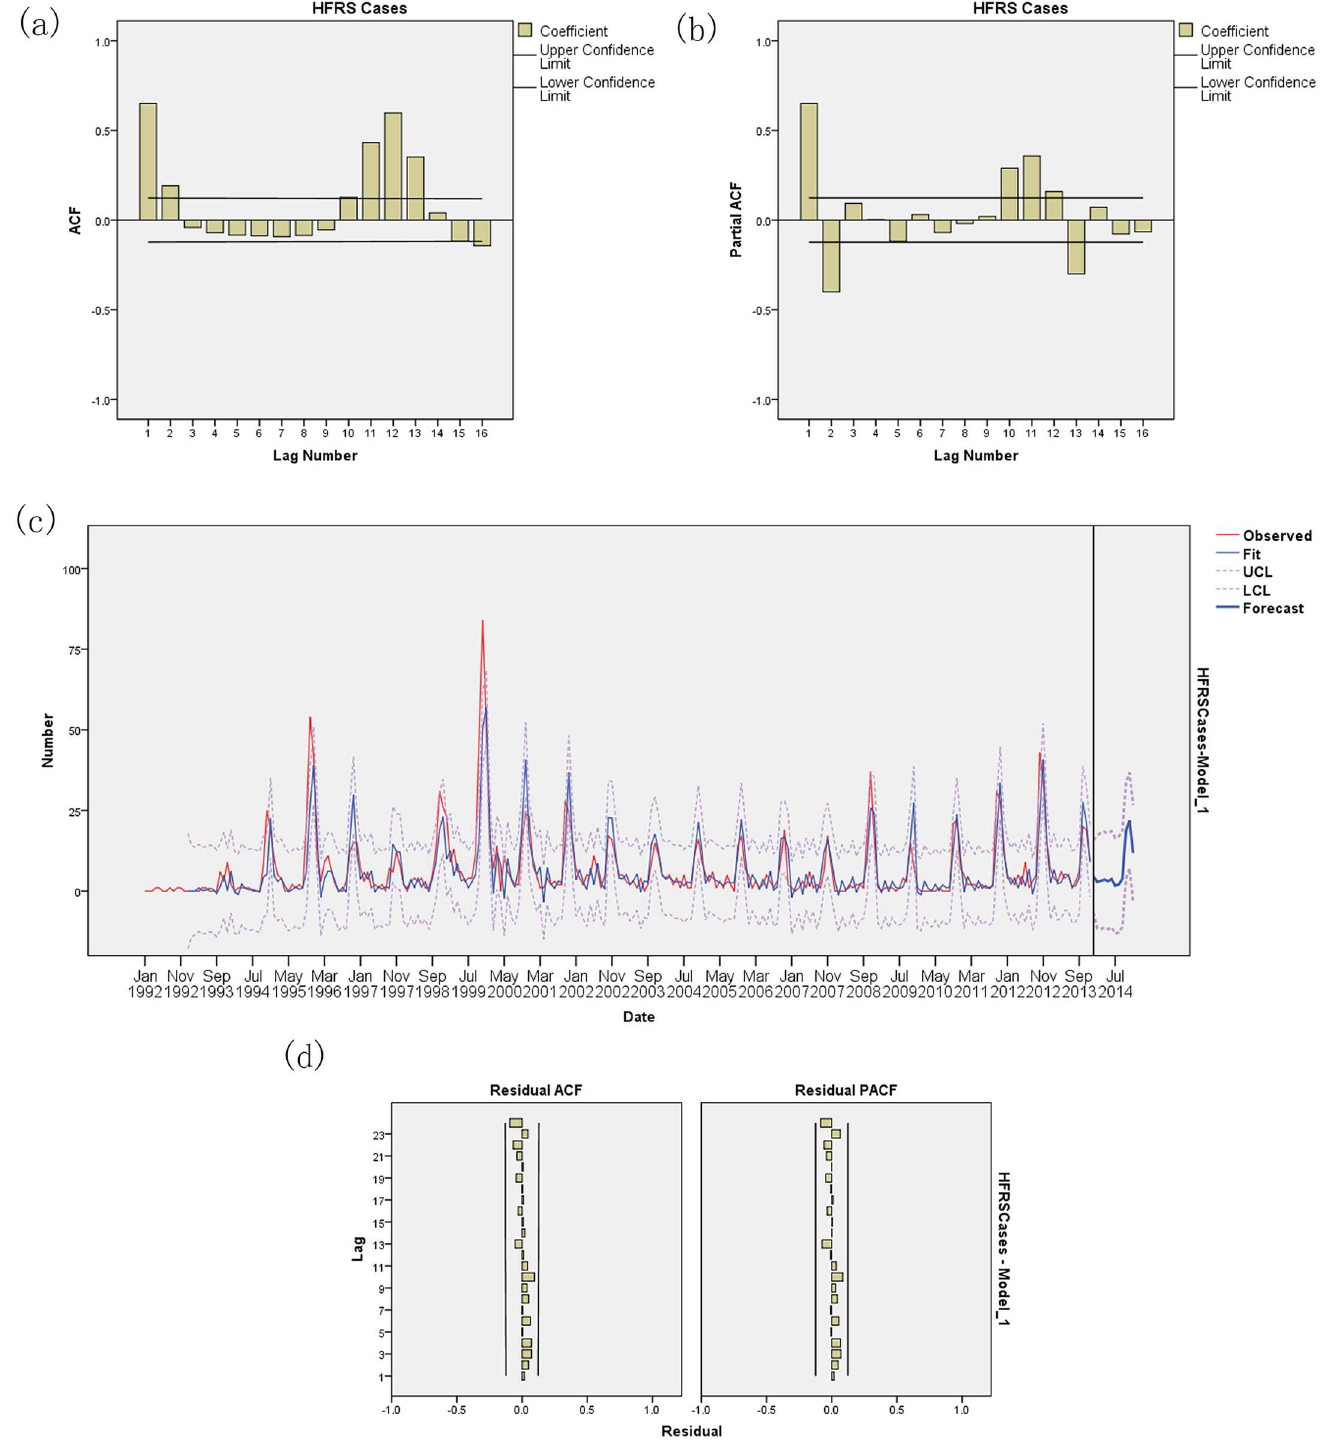
Fig 5. Univariate SARIMA analyses of HFRS cases. (a) Autocorrelation (ACF) plot of HFRS cases; (b) Partial ACF plot of HFRS cases; (c) SARIMA model of HFRS cases; (d) ACF and PACF plots of residualsafter applying a SARIMA model.